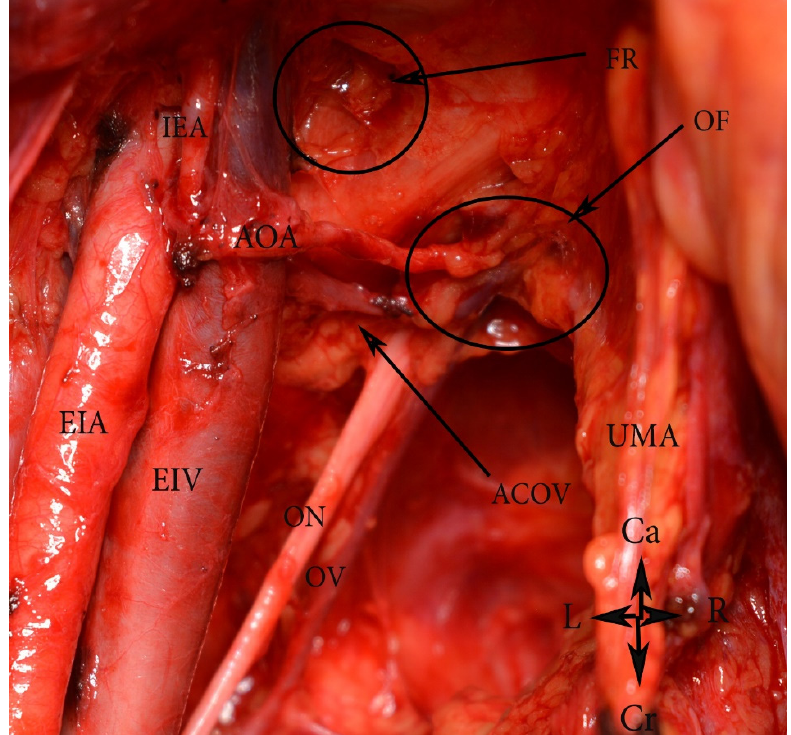
Figure 9 . An aberrant obturator artery arising as a common trunk with the inferior epigastric artery (open surgery). EIA—external iliac artery, EIV—external iliac vein, AOA- aberrant obturator artery, ACOV- accessory obturator vein, ON—obturator nerve, OV- obturator vein, IEA—inferior epigastric artery, UMA—umbilical artery, FR—the deep femoral ring, OF—obturator foramen. Ca—caudal, Cr –cranial, R—right, L—left.